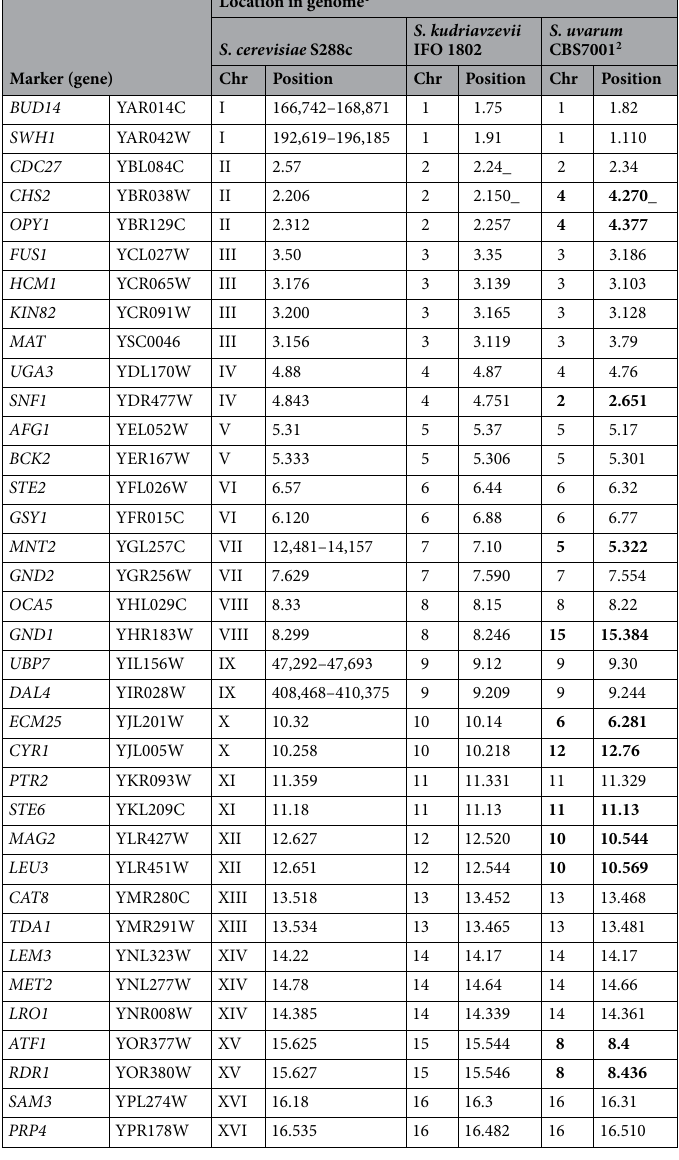
Table 2. List of markers used for the identification of parental chromosomes in the hybrid genomes. 1